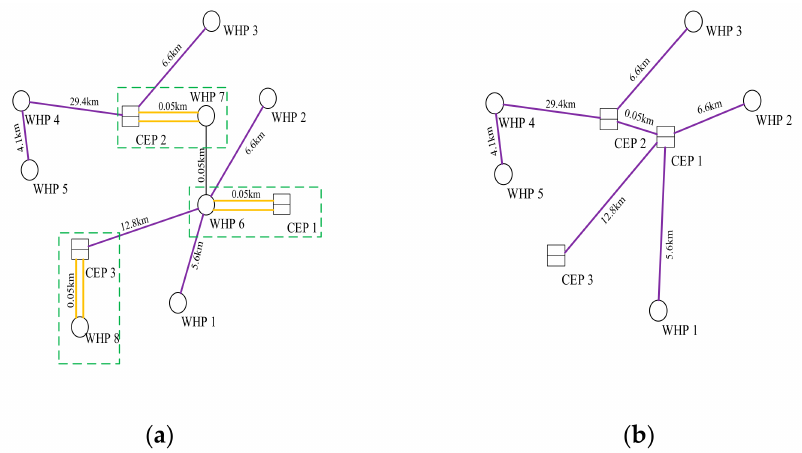
Figure 6. Actual topology diagram of the example power system. ( a ) Topology before simplification; ( b ) topology after